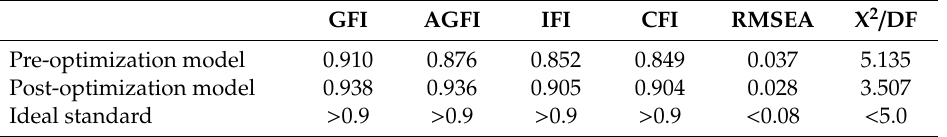
Table 1. Comparison of the fitting indexes before and after model